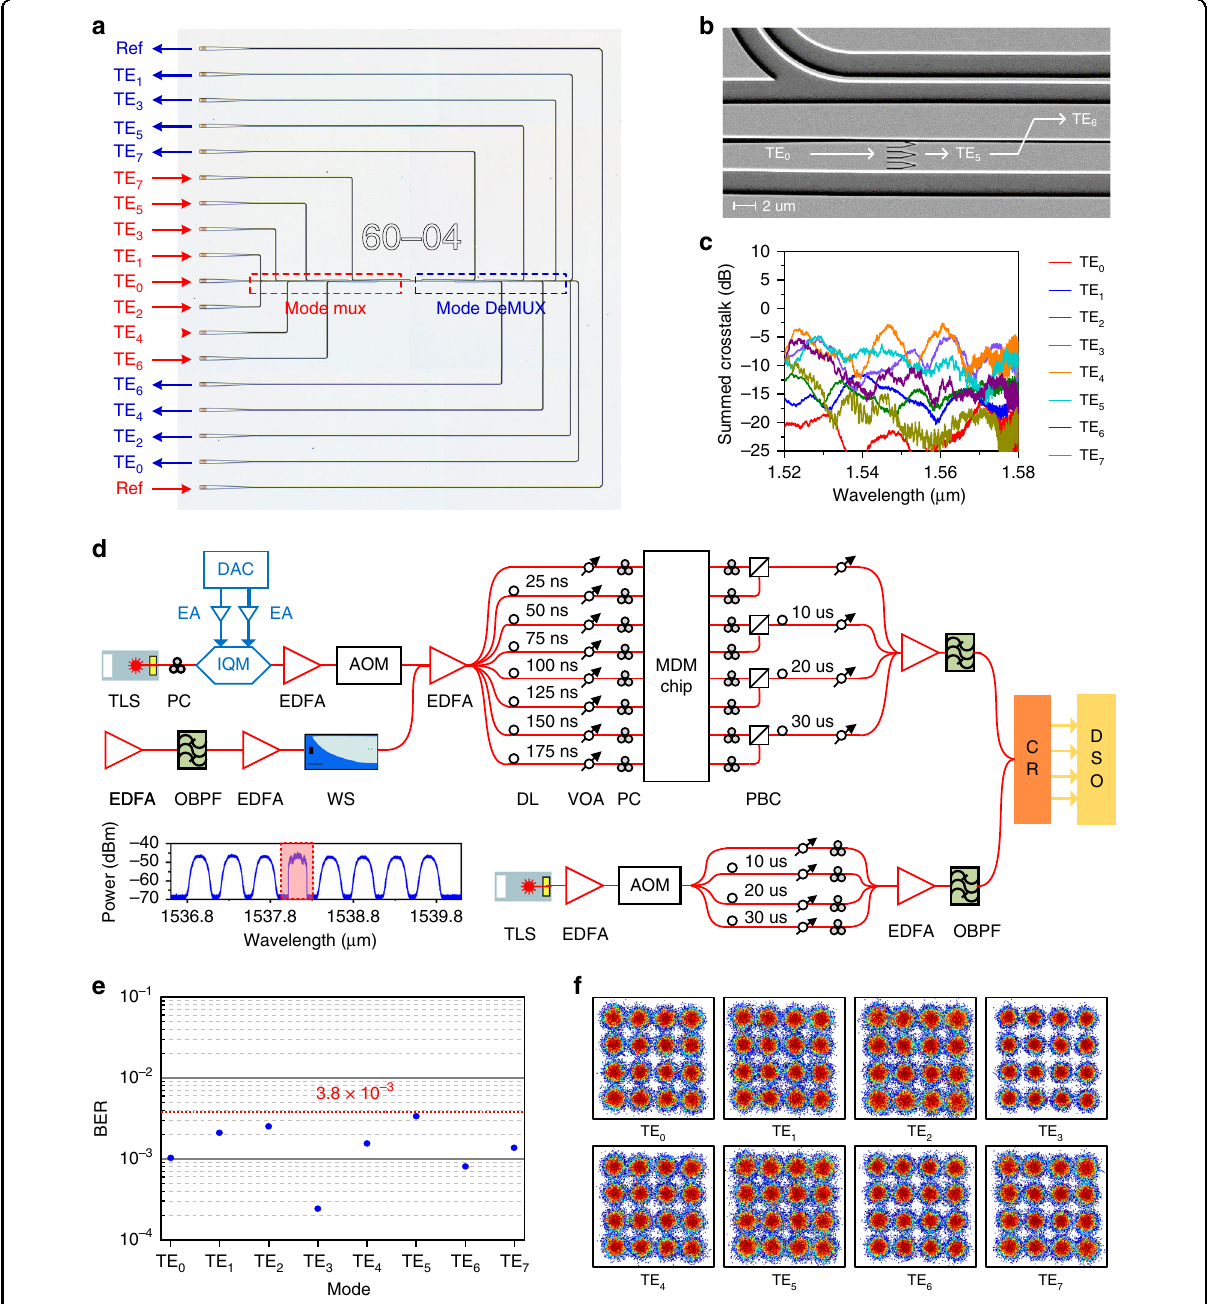
Fig. 5 Eight-mode data transmission of 28-GBaud 16-QAM signals. a Microscope image of the fabricated 8-channel MDM PIC. b SEM image of the two-stage multiplexer for the TE 6 mode, consisting of a metamaterial TE 0 -TE 5 mode operator and a TE 5 -TE 6 ADC. c Measured summed modal crosstalk from the other seven channels for each output port. d Experimental setup for high-speed transmission of 28-GBaud 16-QAM signals. TLS tunable laser source, PC polarization controller, DAC digital-analog converter, EA electronic ampli fi er, IQM in-phase/quadrature modulator, EDFA erbium-doped fi ber ampli fi er, OBPF optical band pass fi lter, WS wave shaper, AOM acousto-optical modulator, DL delay line, VOA variable optical attenuator, PBC polarization beam combiner, CR coherent receiver, DSO digital storage oscilloscope. e Measured bit error rates (BERs) for eight channels. f Corresponding recovered constellation diagrams for eight